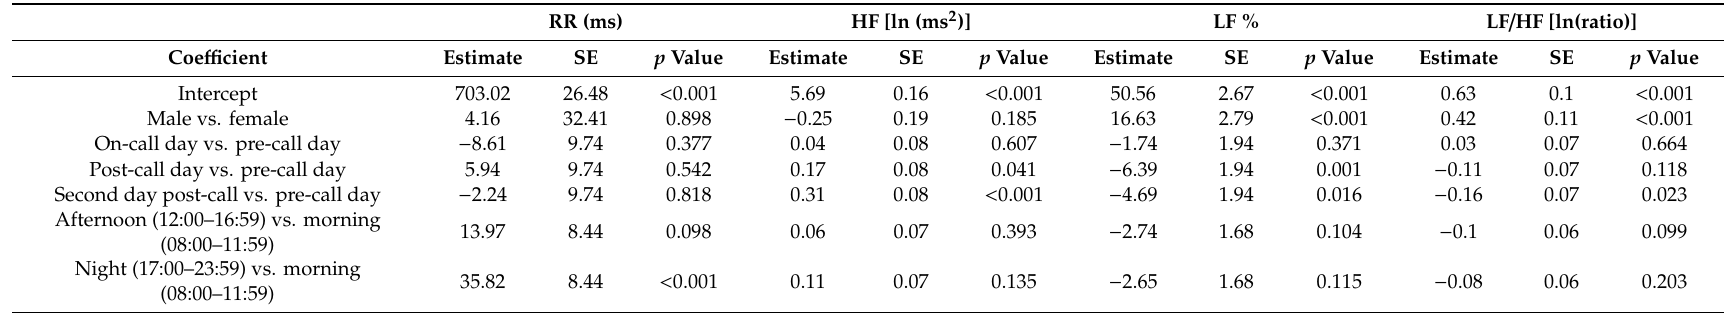
Table 1. Regression coe ffi cients resulting from the construction of a linear mixed-e ff ect model 1 of the HRV among all participants. Four HRV measurements of outcome of interest are R-R interval, HF, LF%, and LF / HF. In this model, the major determinants—gender, duty day, and circadian period—were included as fixed e ff ects. The pre-call day and the morning period were self-control references.